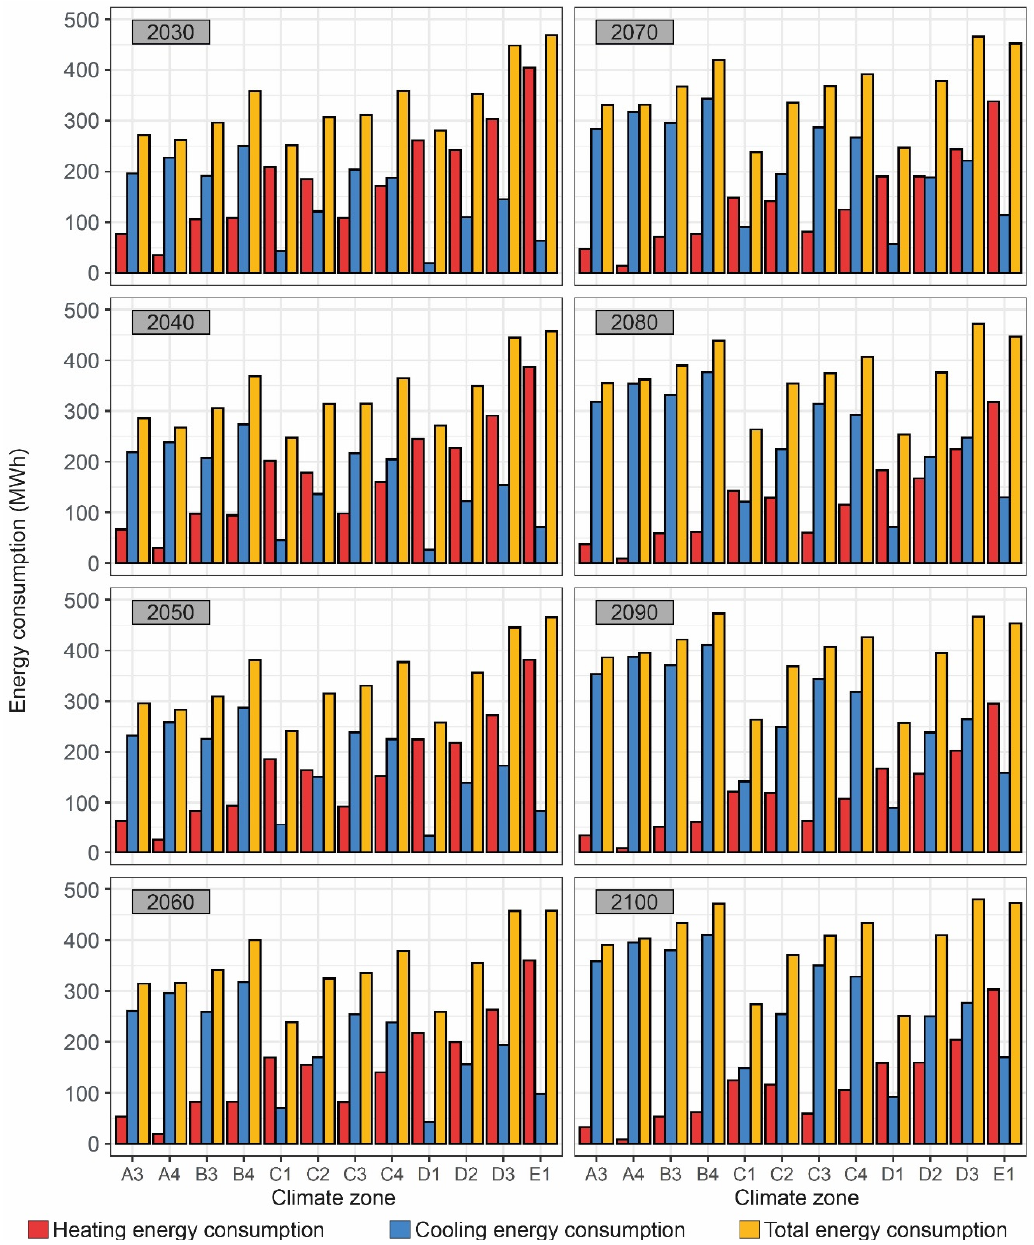
Figure 8. Energy consumption of the building without improving its envelope throughout the 21st century and considering an operational pattern based on teleworking users.